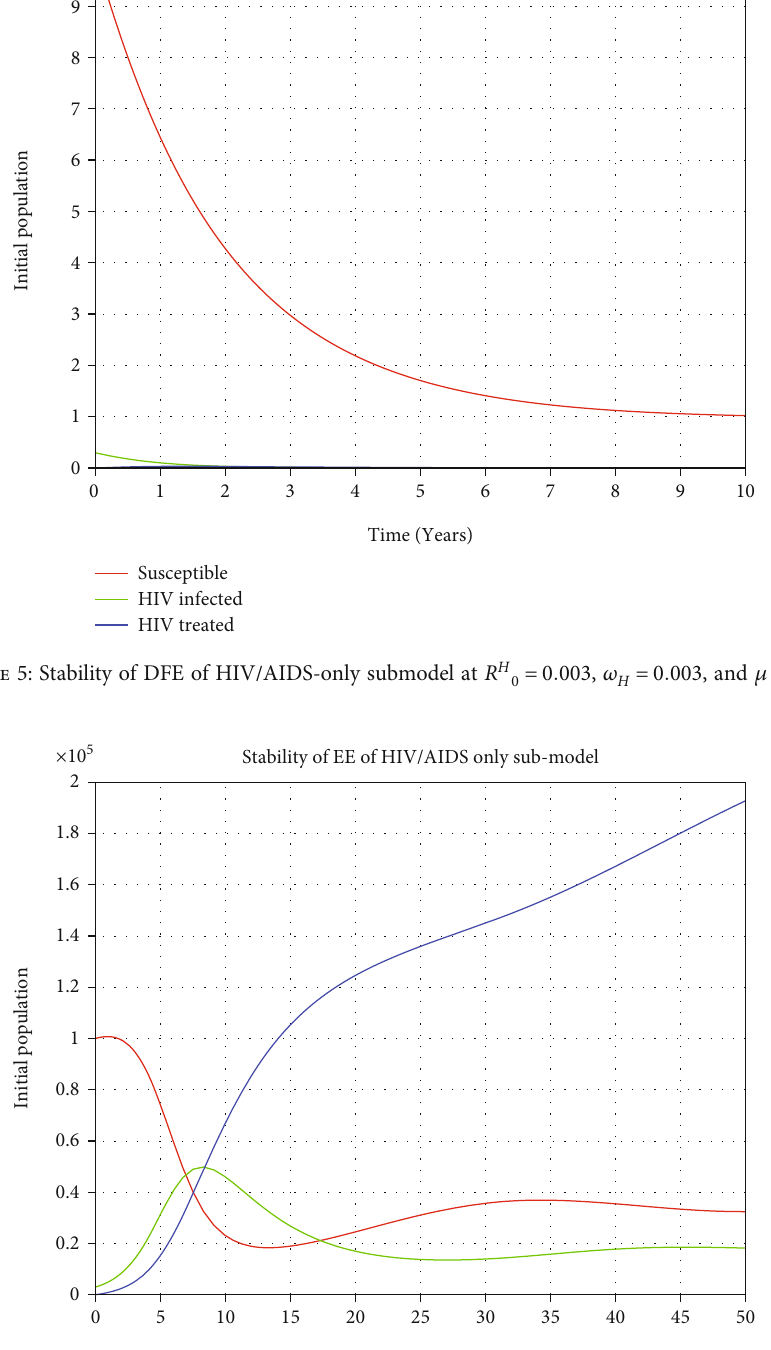
Figure 6: Stability of EE of HIV/AIDS-only submodel at R H